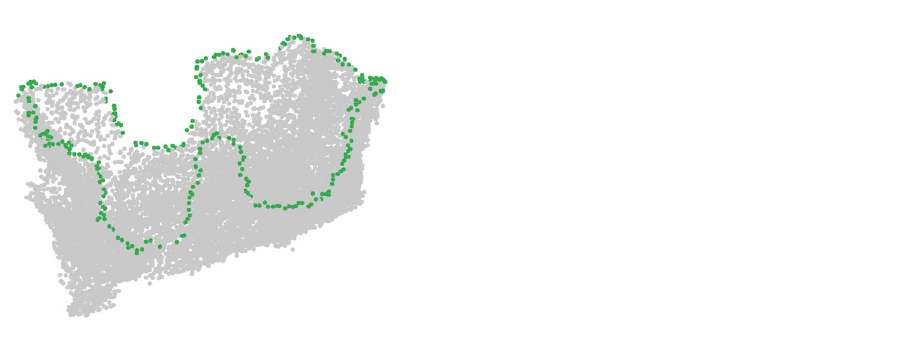
Figure 5. Example of hole boundary point detection result: the green points are the hole boundary points.